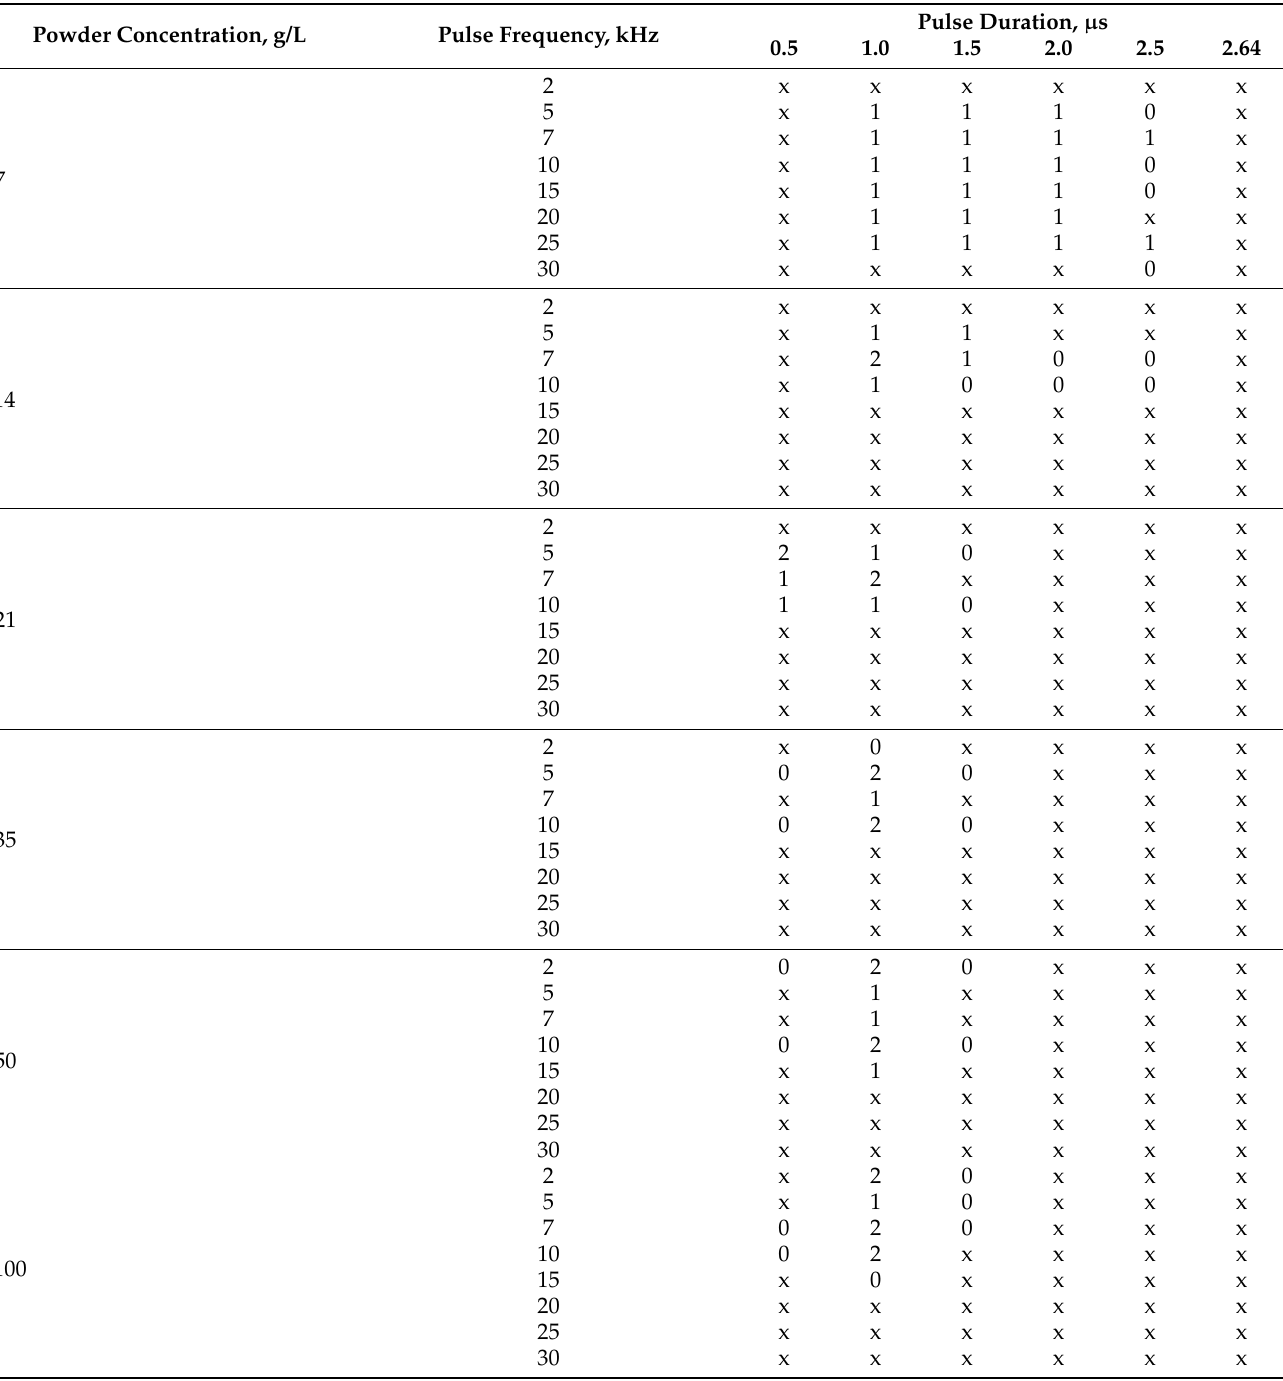
Table 7. Technological gaps of electrical discharge machining alumina in ZnO powder-mixed deion- ized water